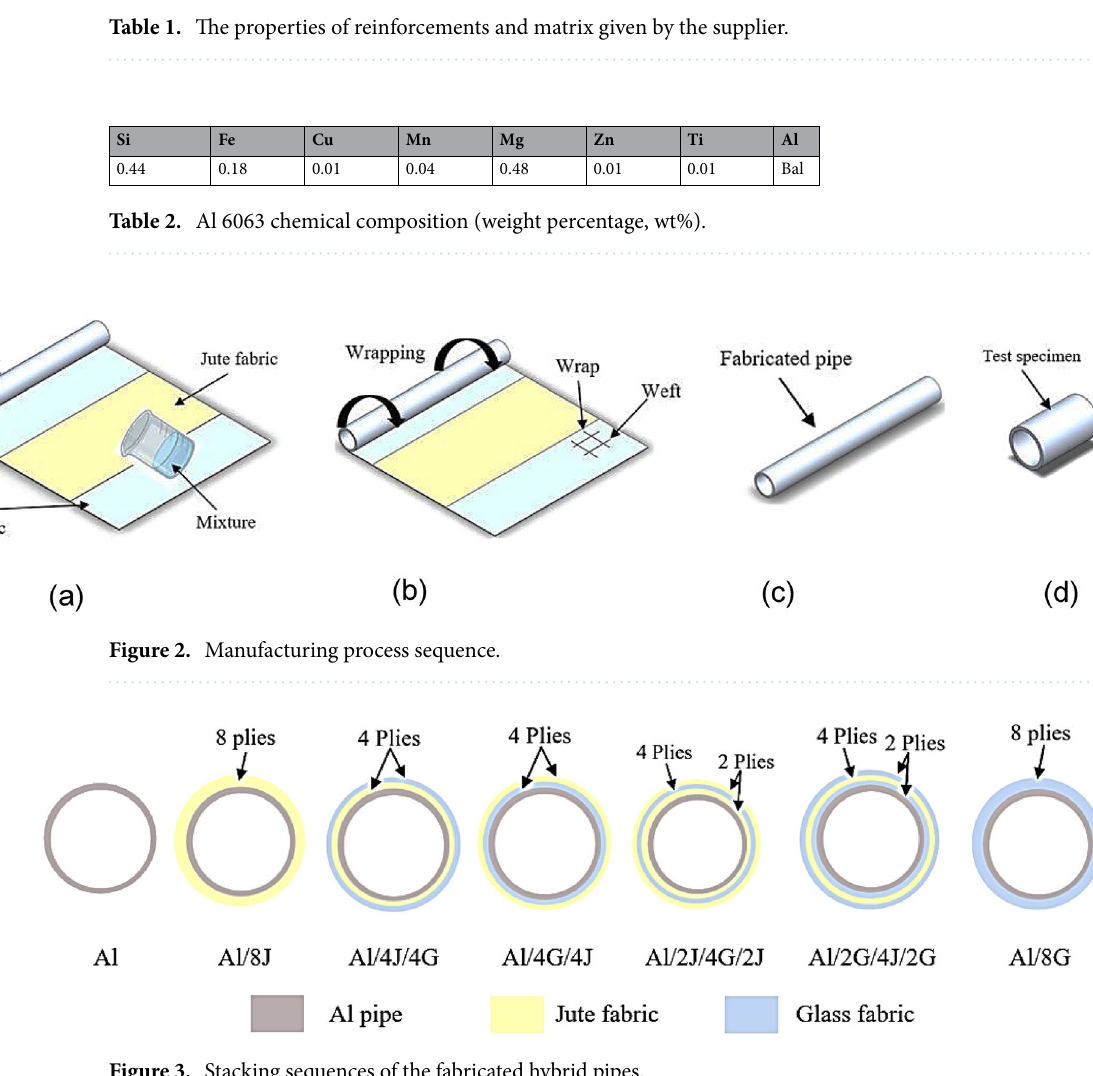
Figure 3. Stacking sequences of the fabricated hybrid